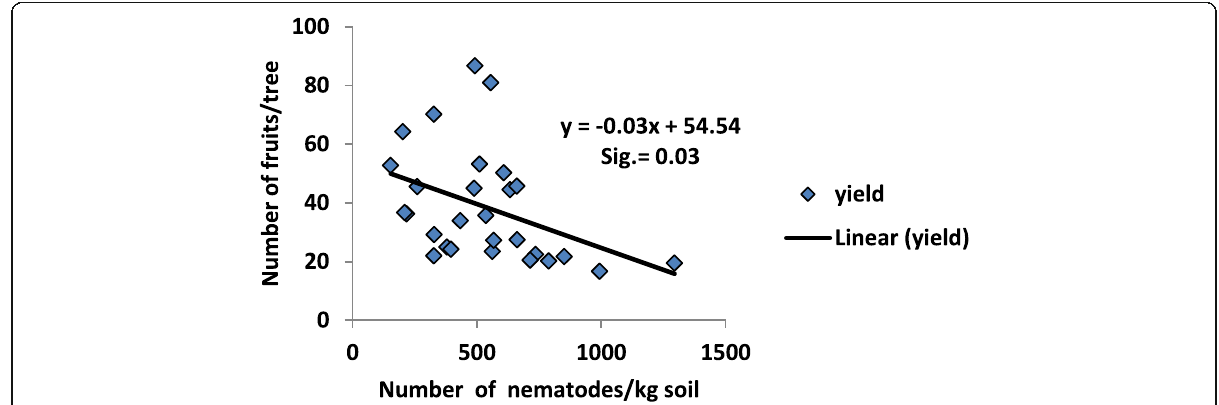
Fig. 1 Relationship between the number of nematodes/kg soil and the number of guava